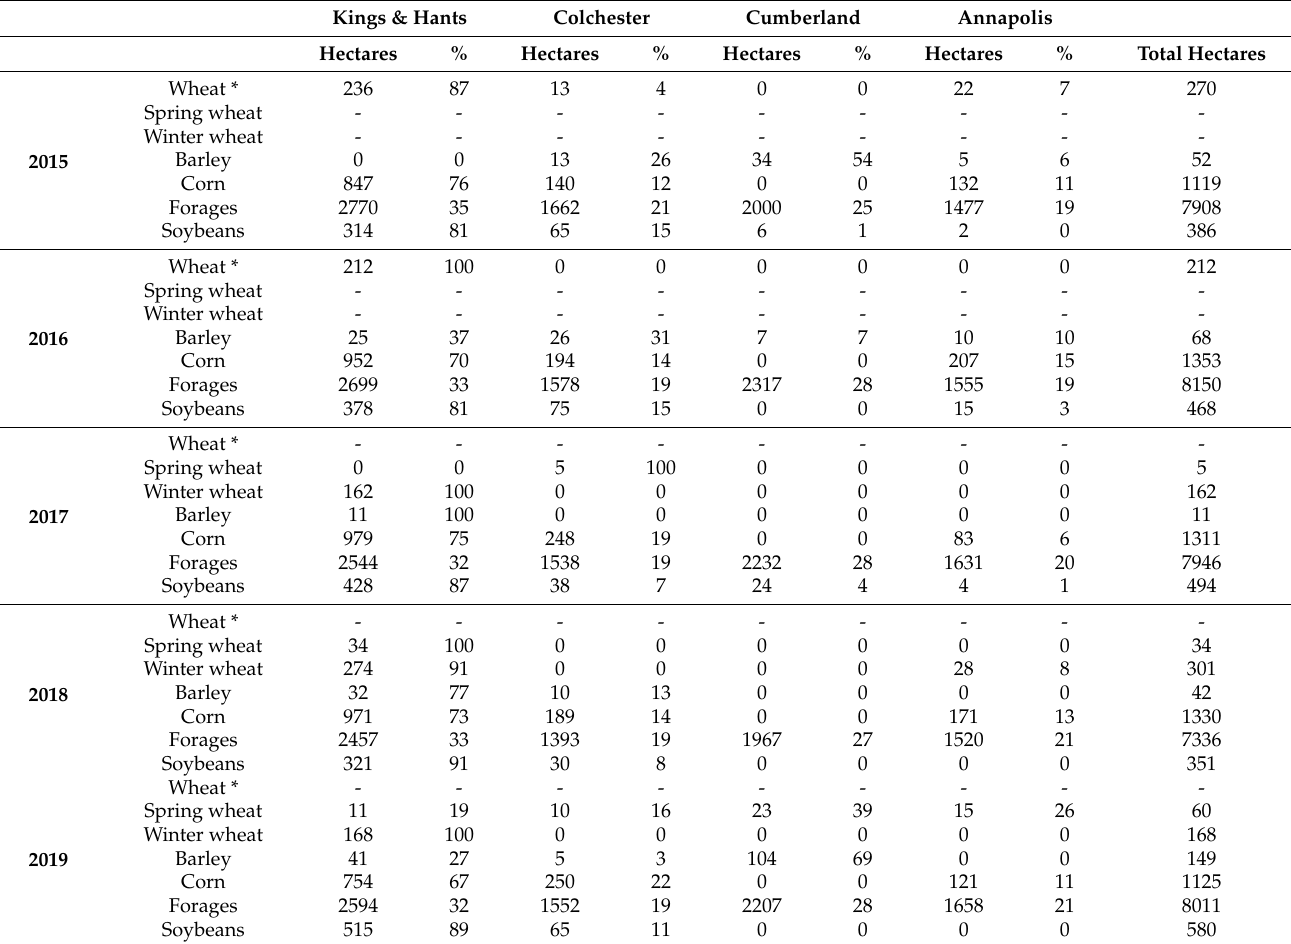
Table 7. Hectares of field crops and forage produced by